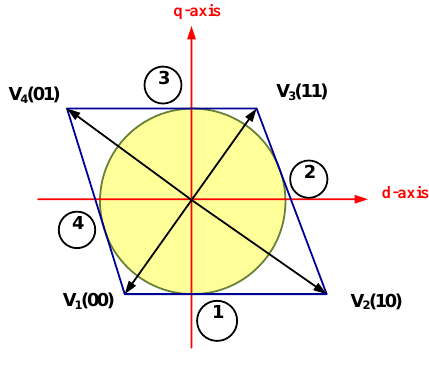
Figure 4. Space vector diagram for FSTPI